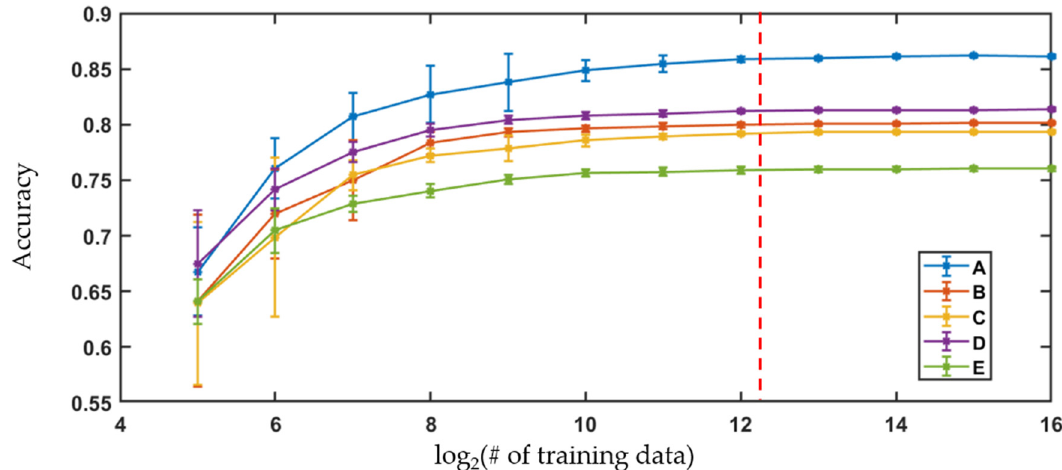
Figure 7. Learning curves showing performance of logistic regression versus number of training data for Sample A–E. Dotted red line = 5000 training data.